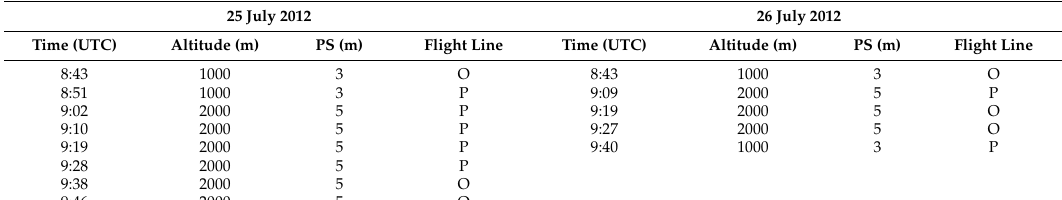
Table 1. The date, time of the flights, altitude above the ground, pixel size (PS), and flight line with respect to the solar principal plane for all the flights. The flight lines are parallel (P) or orthogonal (O) to the solar principal plane.